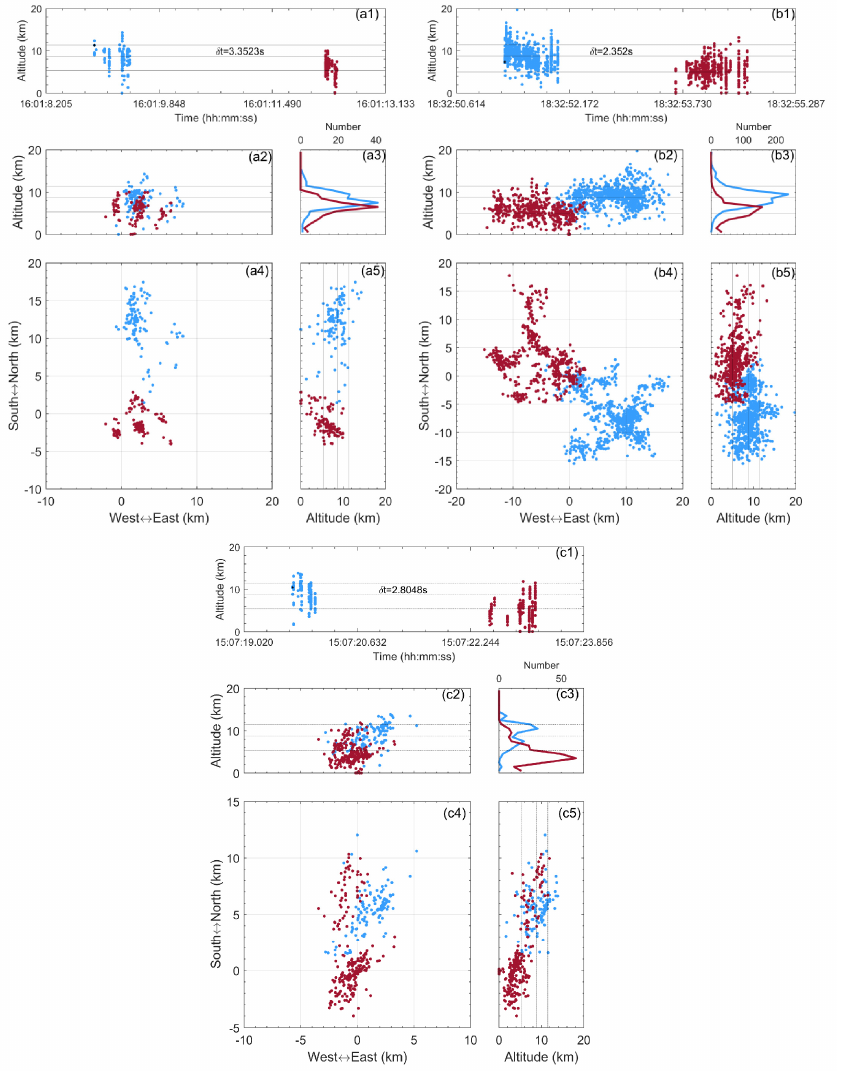
Figure 8. Three TLFs (in red color) and their corresponding NLFs (in blue color) of which the channels propagated into the 5 km radius of the flash-triggered position within 5 s before the TLFs. ( a ): TLF named T20150612160111 and its corresponding NLF; ( b ): TLF named T20150813183254 and its corresponding NLF; and ( c ): TLF named T20170710150722 and its corresponding NLF. ( 1 ): Time vs. height view; ( 2 ): east–west vs. height view; ( 3 ): distribution of sources in height (1 km bins); ( 4 ): plan view; and ( 5 ): south–north vs. height view. The dashed lines mark the isotherms of 0, − 20, and − 40 °C from bottom to top. The black dot is the initiation height of the NLF in 1.